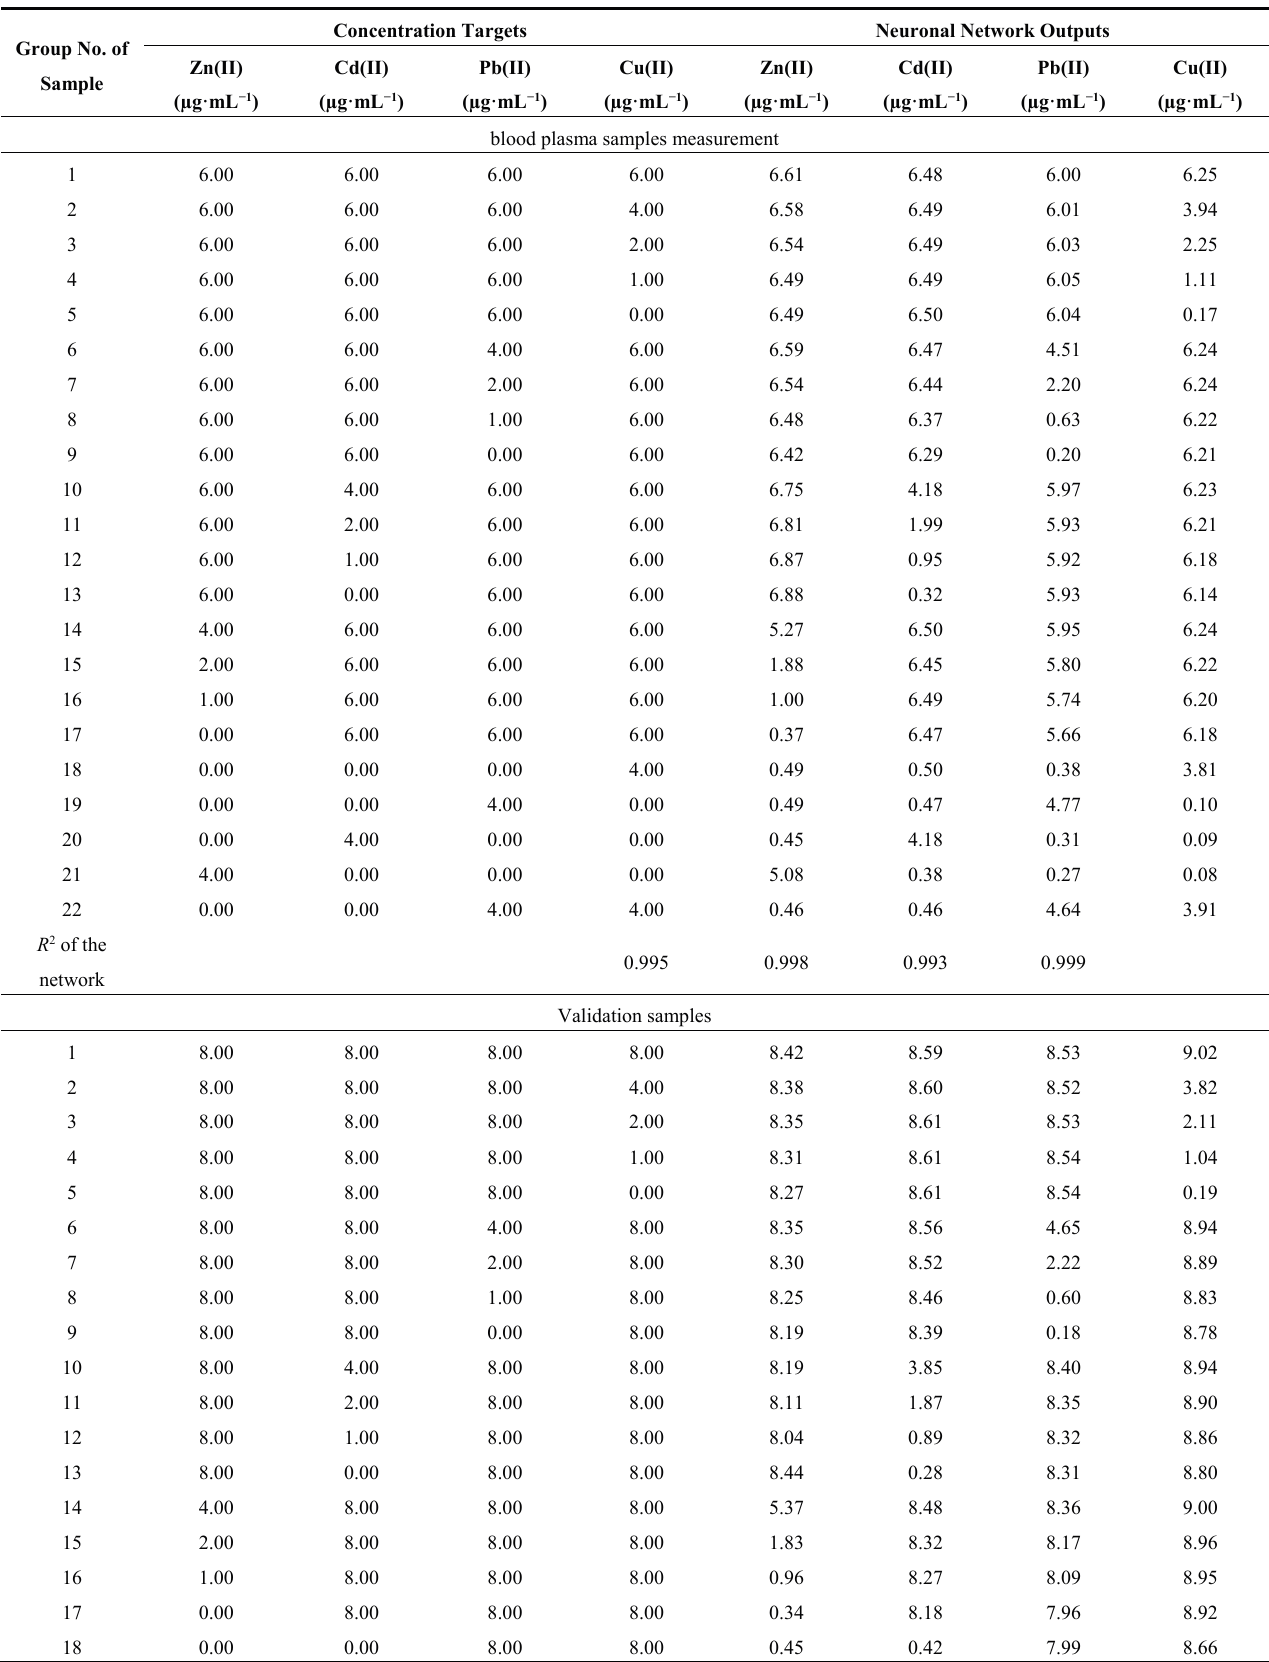
Table 3. Employment of the network on the measurement of the artificial blood plasma samples and set of validation